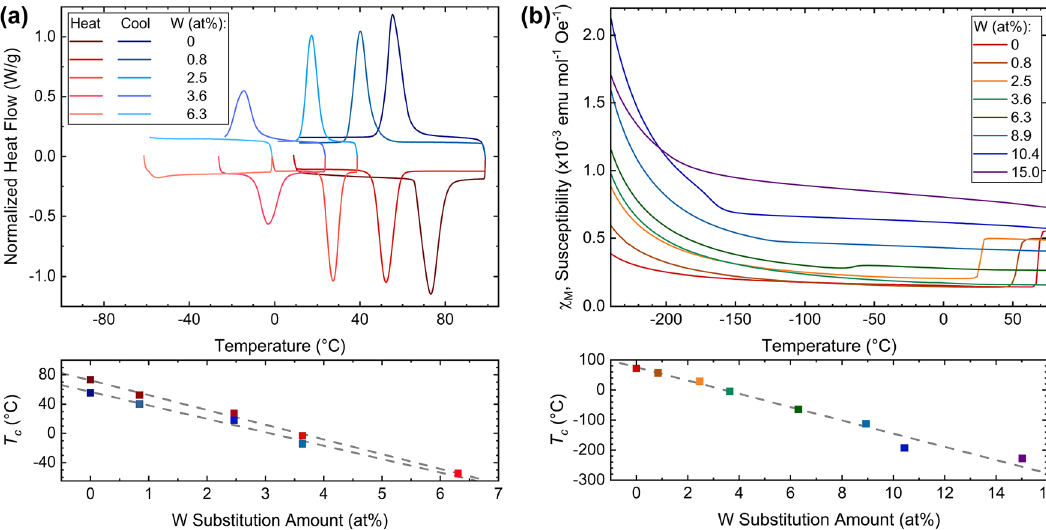
Figure 6. DSC and SQUID magnetization experiments determined the MIT for the tungsten substitution series. The two data sets agree with each other in the rates of T c depression despite DSC containing a partial data set compared to SQUID. This T c depression rate also agrees with the structure phase transformation rate from in-situ PDF during heating and